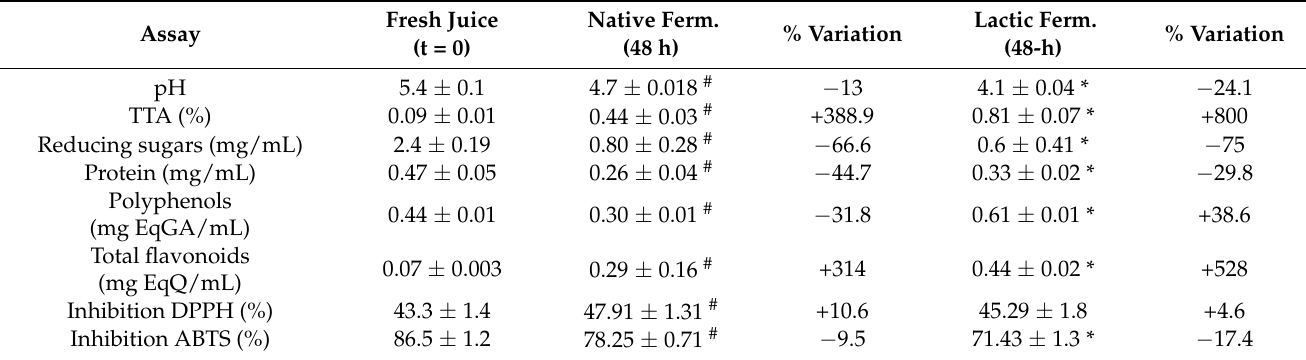
Table 4. Comparative between parameters at 48 h of native and lactic fermentation against fresh